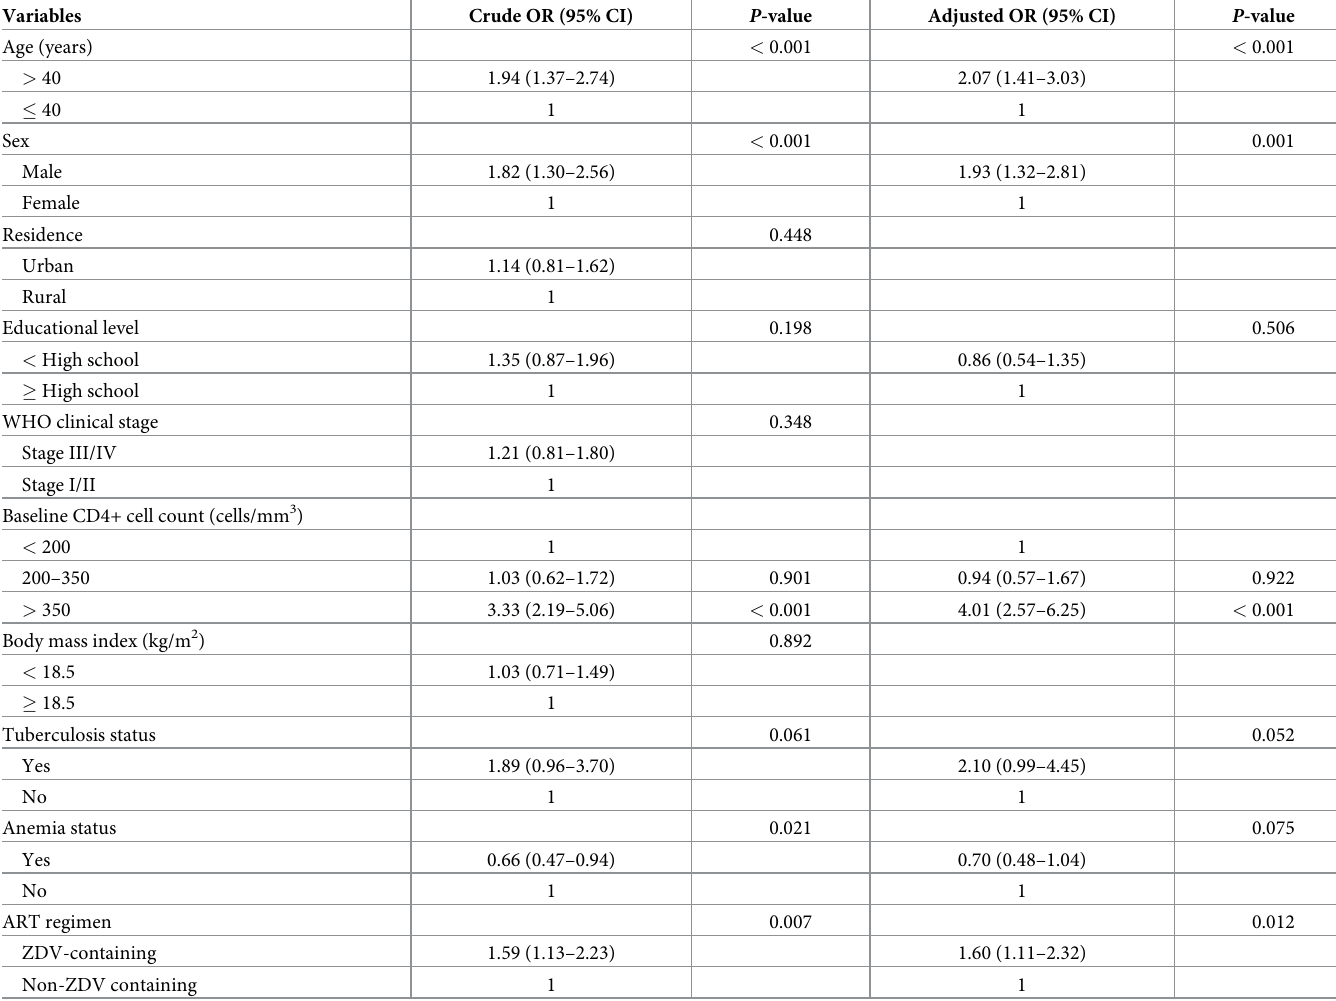
Table 2. Factors associated with poor CD4+ cell count recovery (an increase of � 100 cells/mm 3 from baseline) at 12